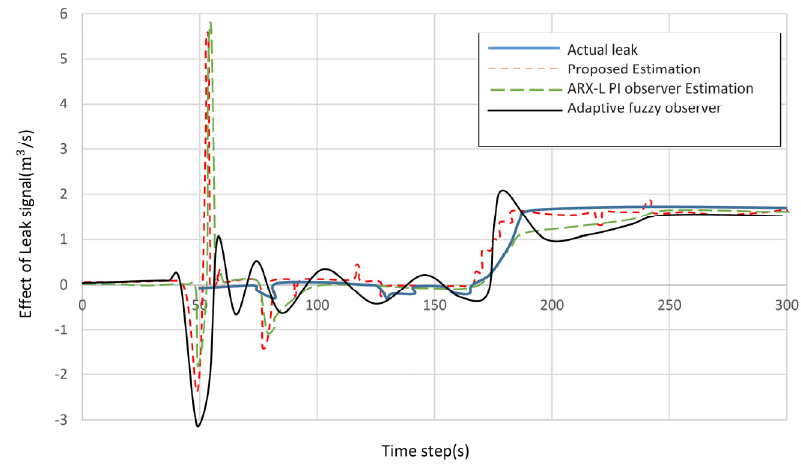
12 of 14 Figure 10. The error between the predicted output and the expected output based on the proposed